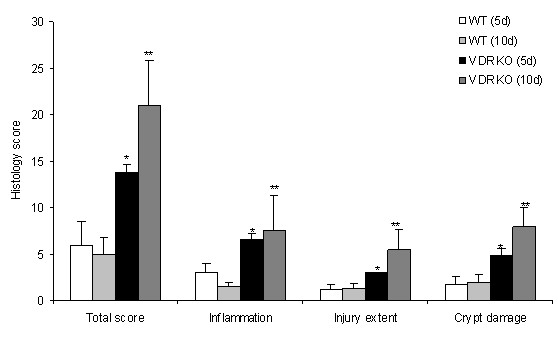
Histology scores in mice treated with DSS. Colonic injury score in WT and VDR KO mice that received 2.5%DSS at 5 or 10 days post-administration. Scores were determined as described in Materials and Methods. * VDR KO values were significantly different than WT mice at 5 days post-DSS. ** VDR KO values were significantly different than WT at 10 days post-DSS.